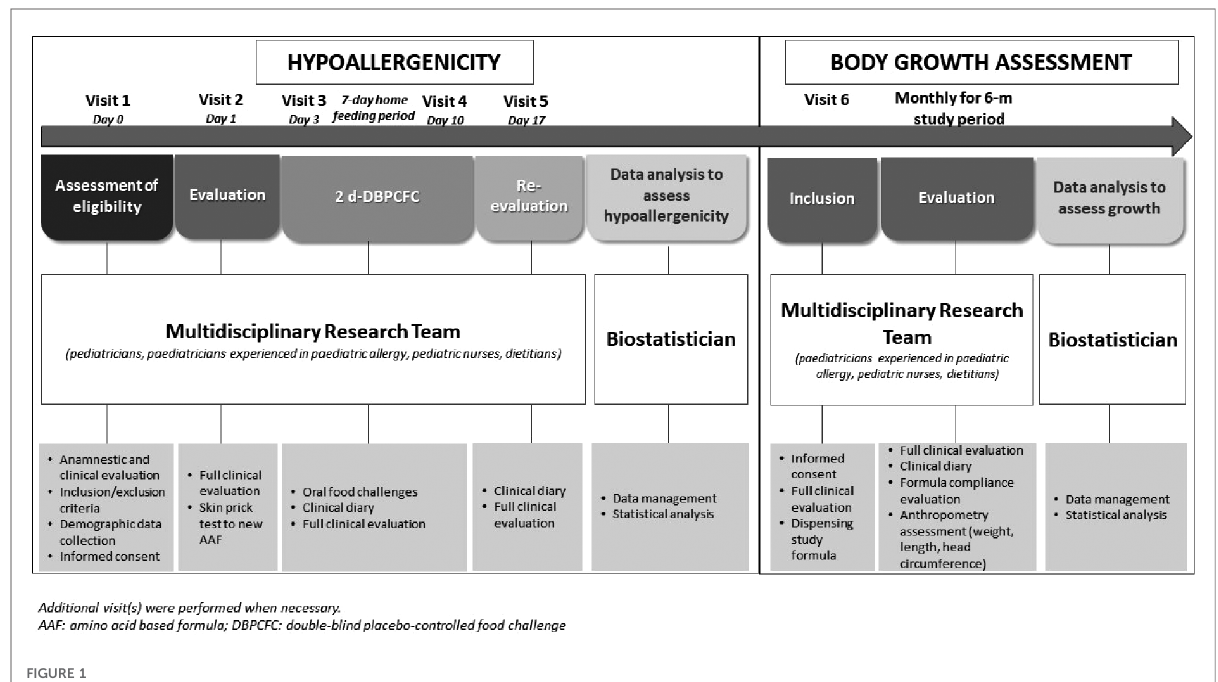
FIGURE 1 The design of the